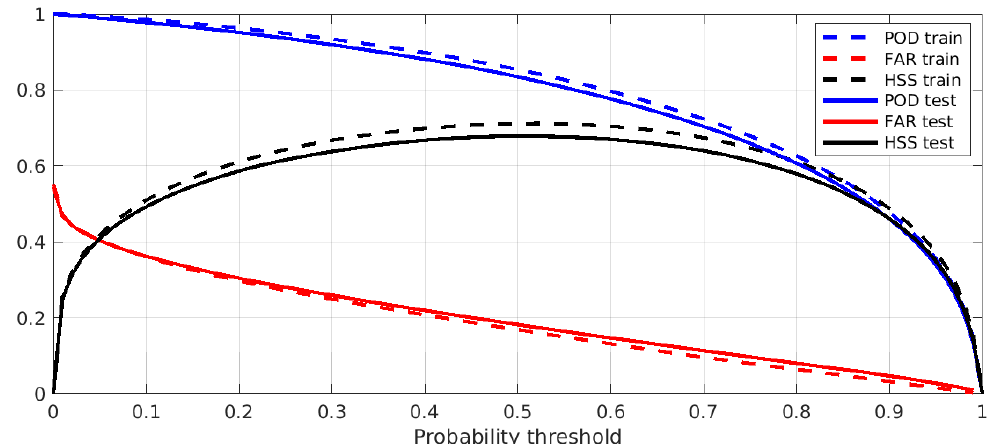
Figure 6. Snow rate detection statistics. Statistical indexes (POD, FAR, and HSS) for the SD module applied to test and training datasets.